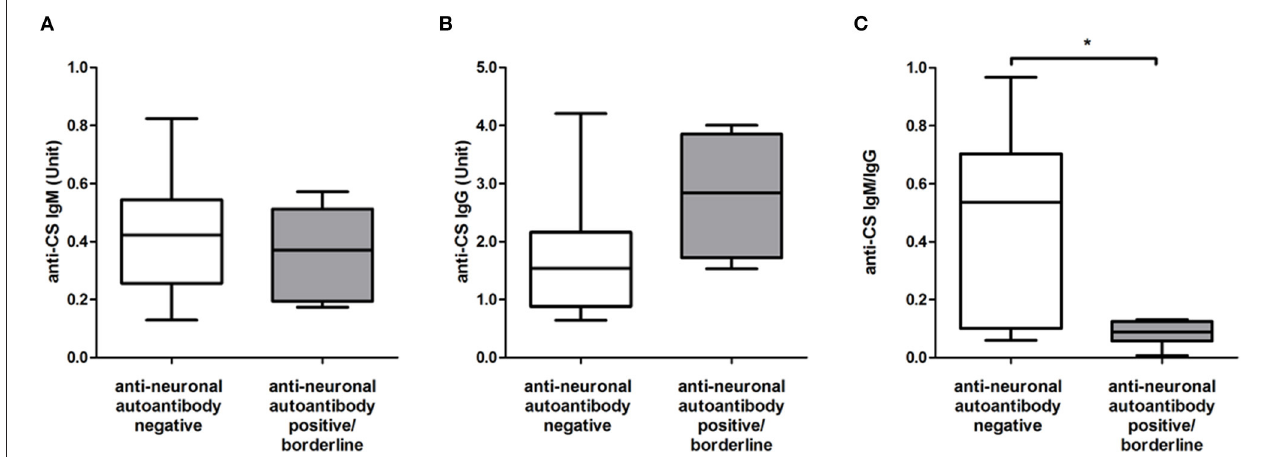
FIGURE 1 | The level of anti-citrate synthase (CS) IgM (A) , IgG (B) , and autoantibodies and their ratio (C) in patients with positive/borderline ( n = 8) and negative ( n = 14) results for anti-neuronal autoantibodies. The boxes show interquartile ranges (IQR); the horizontal lines represent medians and the whiskers indicate the lowest and highest values. * p <